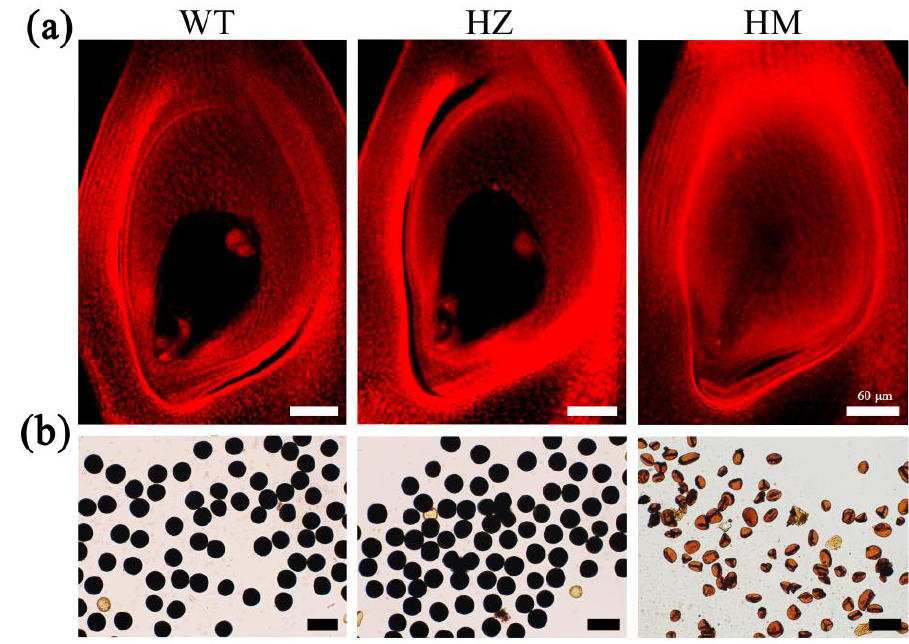
Figure 3. Phenotype characteristics of male and female gametophytes in rice heterozygous and homozygous mutants. ( a ) Pictures of ovary transparency, displaying defective embryo sac in homozygous mutants (HM) compared with wild type (WT) and heterozygous (HZ). ( b ) Pictures of pollens stained with KI-I 2 , showing abortion pollens in HM mutants compared with WT and HZ. Scale bars represent 60 µm.